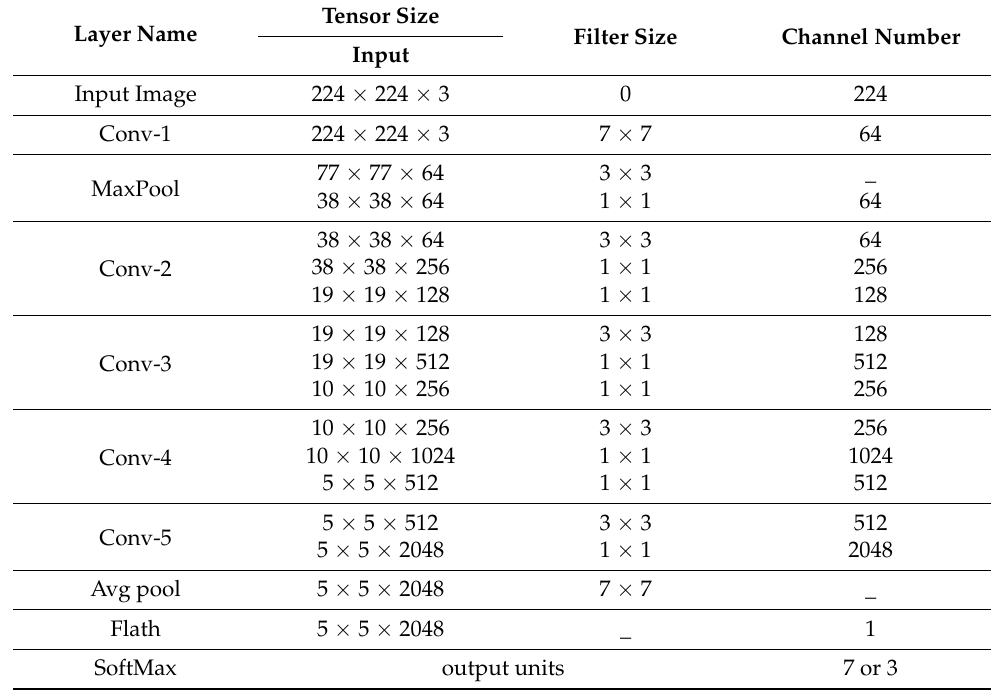
Figure 9. The structure of the ResNet-50 model used in this study. Table 1. The detailed structure of the convolutional neural network of the ResNet-50 model.